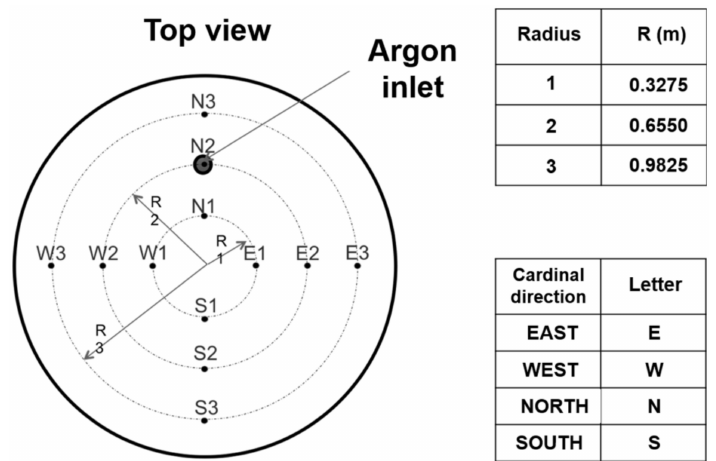
Figure 2. Falling points of additions over the top of the bath. Each point corresponds to a vertical plane located in the N–S and E–W axes. The top table indicates the distances from the ladle center.